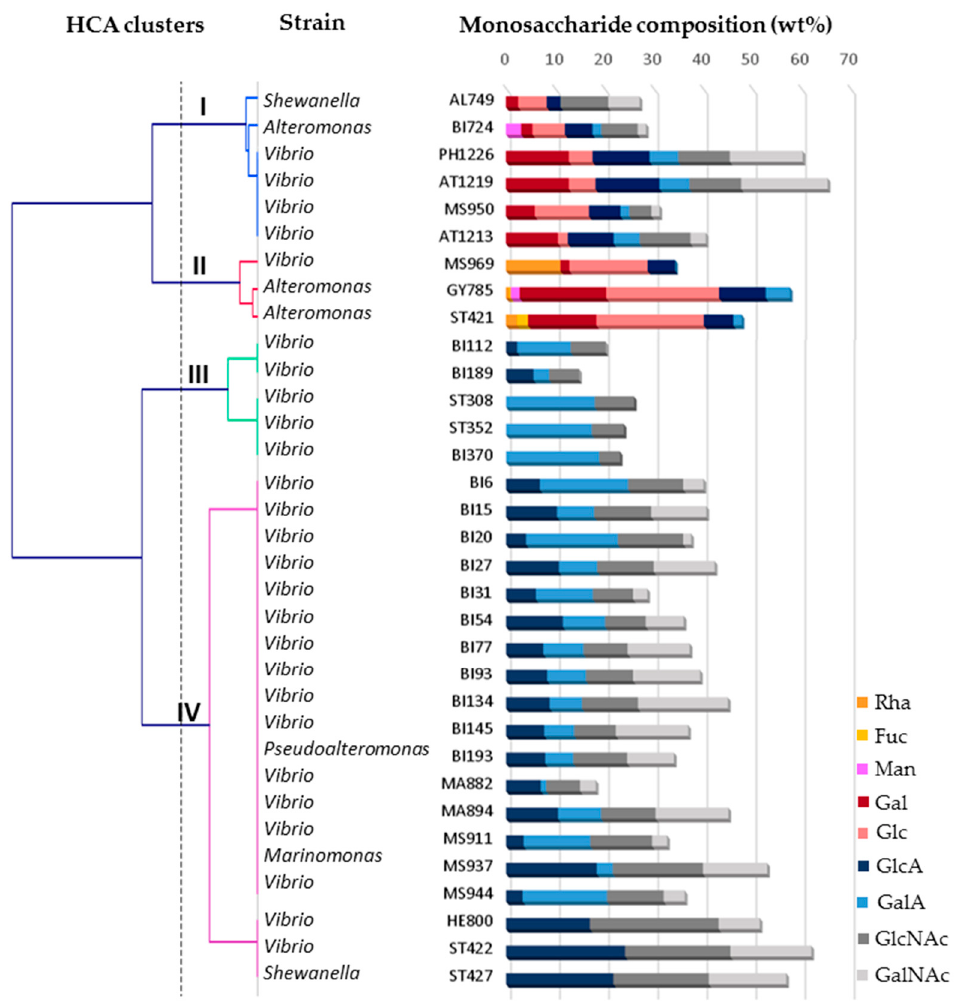
Figure 2. HCA clusters, bacterial strain identification and monosaccharide composition (wt%) of the EPS produced at laboratory scale. GY785 EPS and HE800 EPS were used as references.